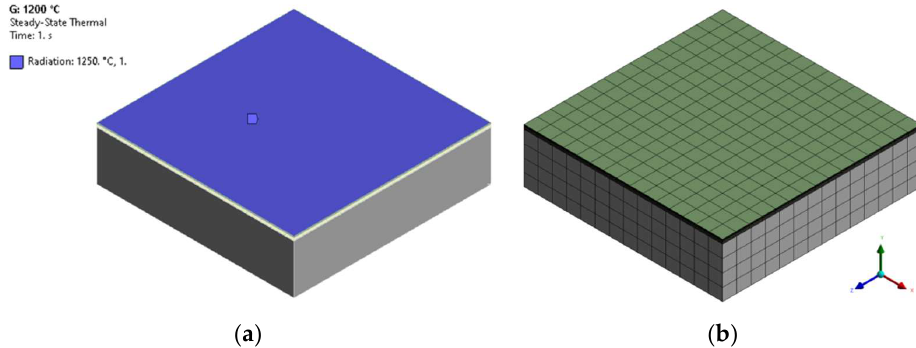
Figure 2. ( a ) TBC model in ANSYS and ( b )